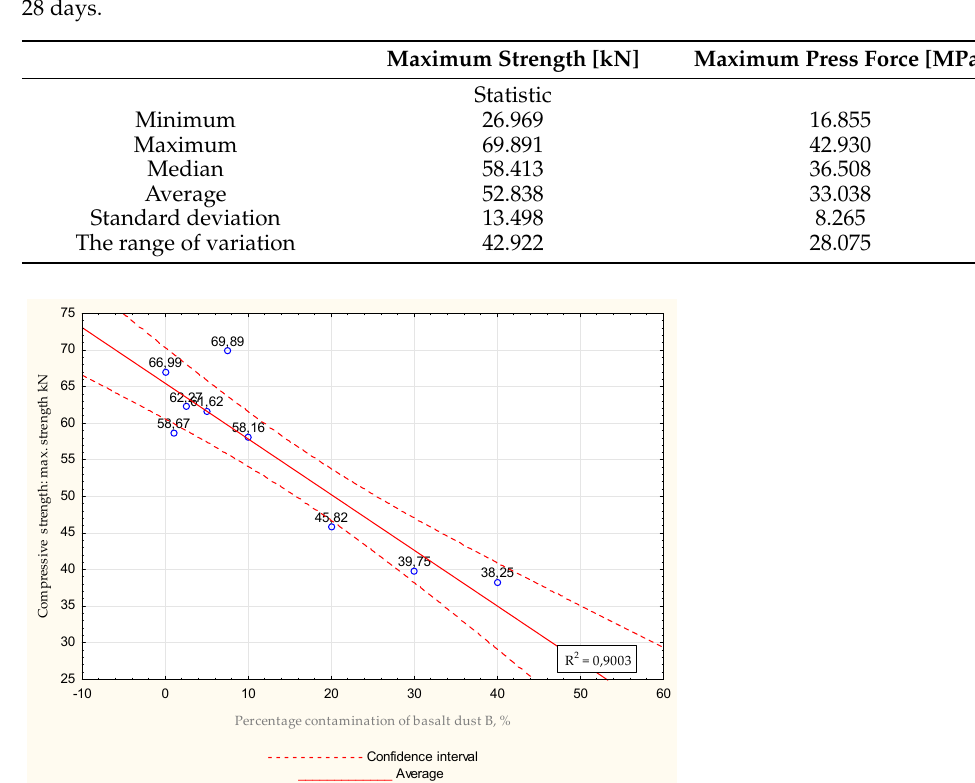
Figure 29. Average values obtained during compressive strength tests after 28 days for water − mix ratio = 0.5, max. strength.